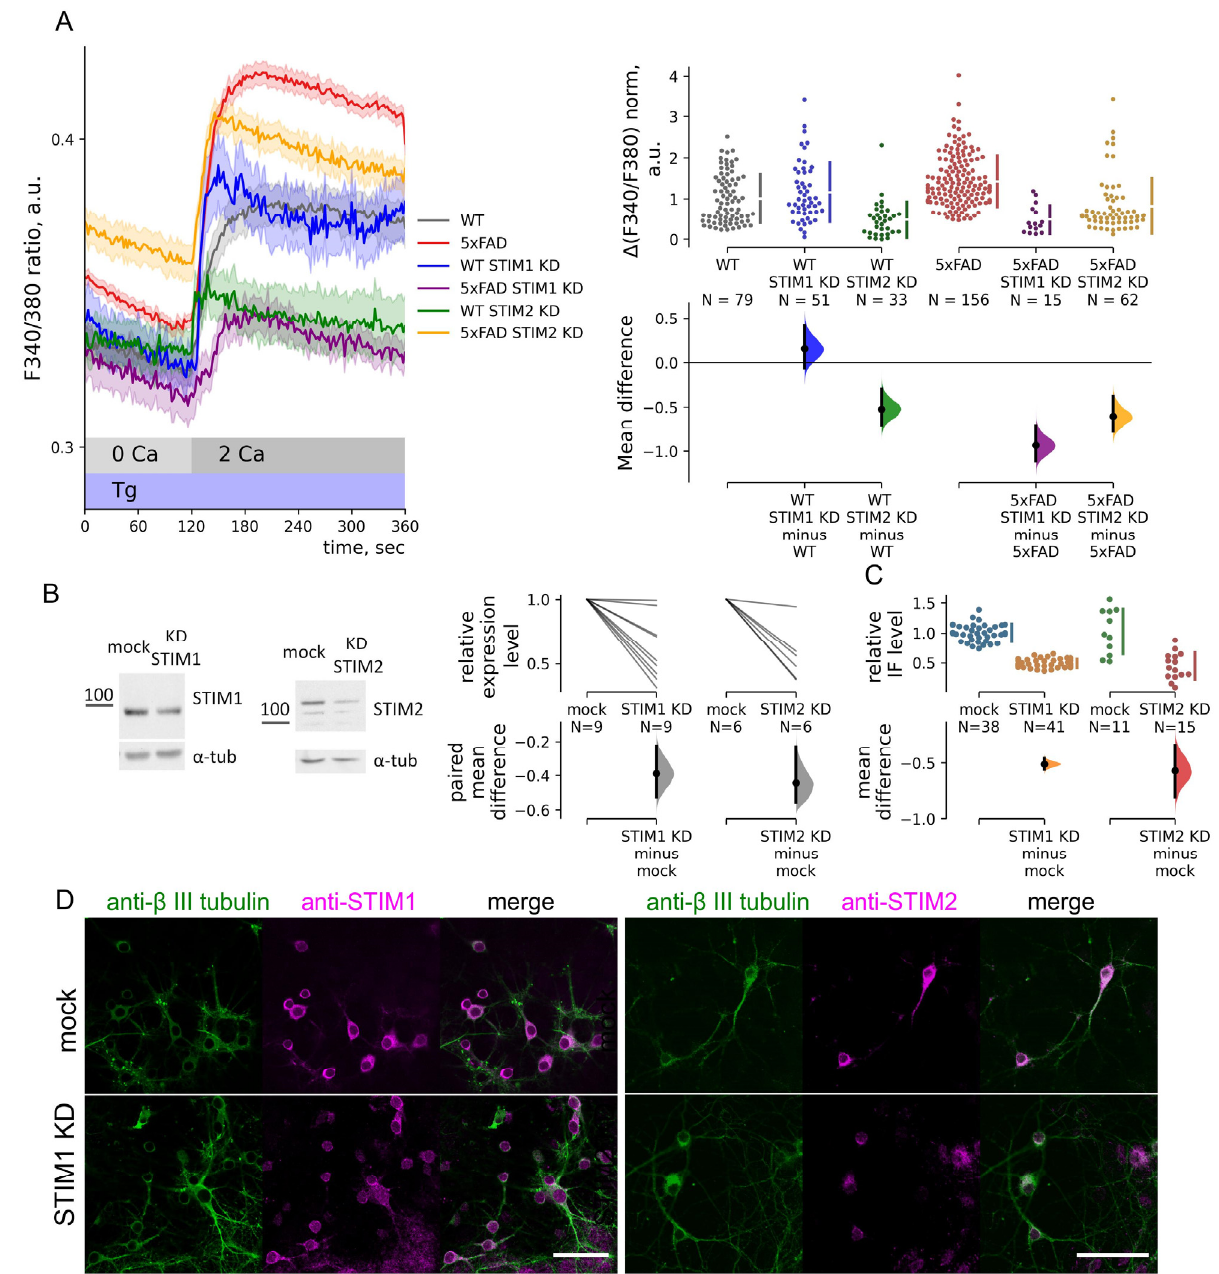
Figure 3. Store-operated calcium entry regulation by STIM1/2 proteins is changed in 5xFAD hip- pocampal neurons. ( A ) Calcium imaging with Fura2 of neurons of primary hippocampal cultures of wild-type (WT, gray) or 5xFAD (red) mice and treated with STIM1/STIM2 shRNA lentiviruses (STIM1 KD and STIM2 KD) or mock shRNA lentivirus. Mean traces of F340/380 ratio are repre- sented as mean ± SEM. Thapsigargin (Tg) was added to deplete internal calcium stores. Calcium entry ( Δ F340/F380) was calculated as the F340/F380 peak of each trace after Ca 2+ add-back, and the baseline was subtracted. Δ F340/F380 data are normalized by the mean WT calcium entry and shown in the estimation plot. Δ F340/F380 data are plotted on the upper axes; mean differences are plotted on floating axes on the bottom as bootstrap sampling distributions. The Kruskal–Wallis ANOVA ( p < 0.0001) with post-hoc Dunn’s test was implemented; pairwise p -values were calcu- lated. Mean differences between calcium entry in WT and WT STIM1 KD or WT STIM2 KD neu- rons are 0.15 and − 0.52; p = 1.0 and 2.3 × 10 − 4 compared to WT neurons. The mean difference be- tween calcium entry in 5xFAD and 5xFAD STIM1 KD or 5xFAD STIM2 KD neurons are − 0.94 and − 0.61; p = 1.8 × 10 − 7 and 6.4 × 10 − 11 compared to 5xFAD. ( B ) Western blots with neuronal culture ly- sates. Neurons were treated with STIM1/STIM2 shRNA lentiviruses (STIM1 KD and STIM2 KD) or